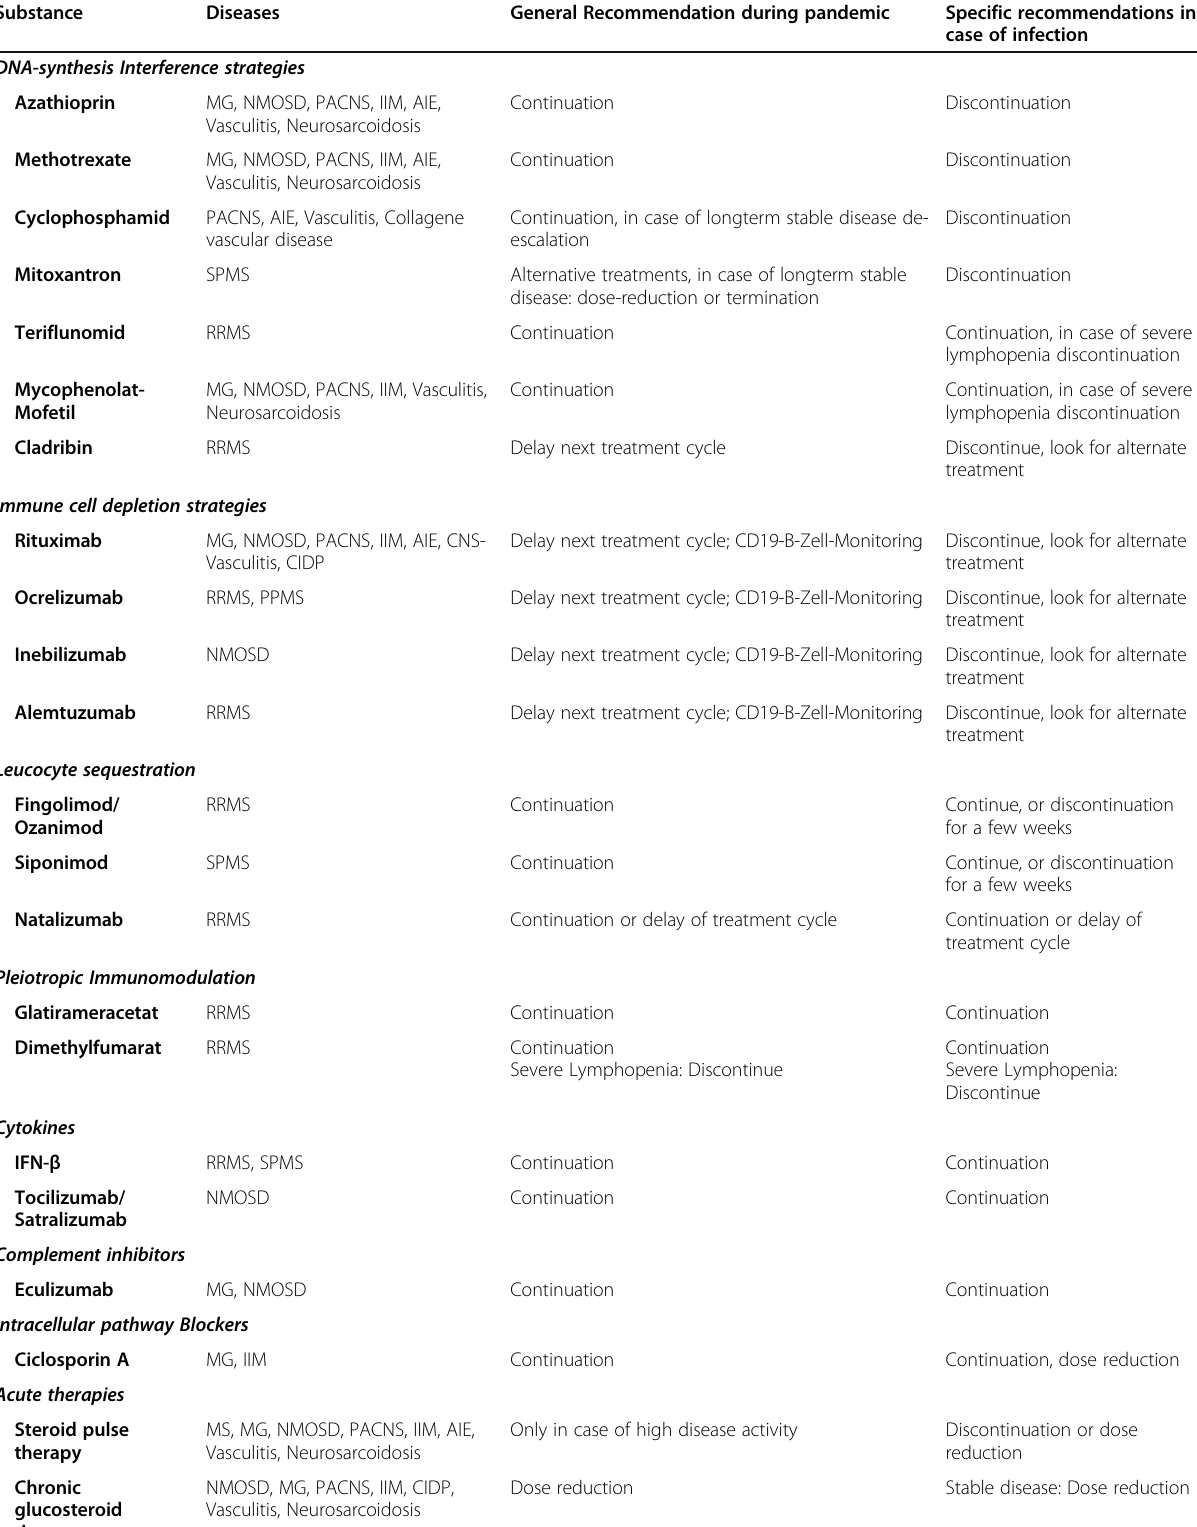
Table 1 Overview of the most frequently applied immunotherapies for neurological diseases and corresponding recommendations regarding their application in times of